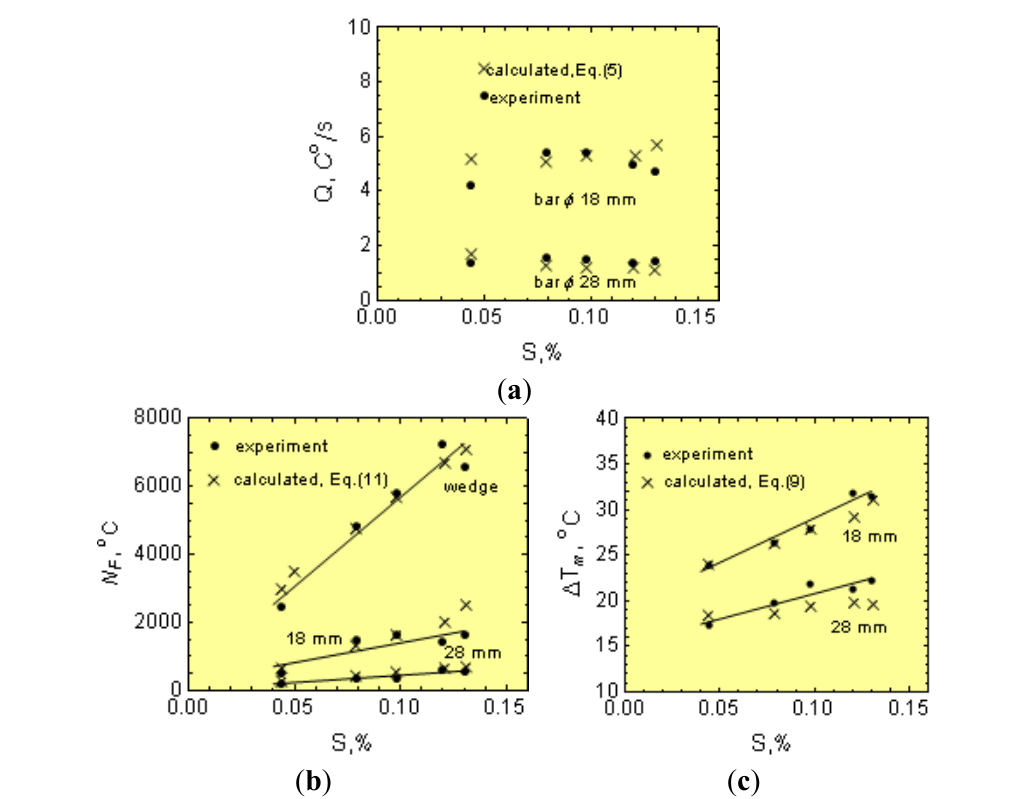
Figure 22. Effect of sulfur on ( a ) Q , ( b ) N F and ( c ) Δ T m